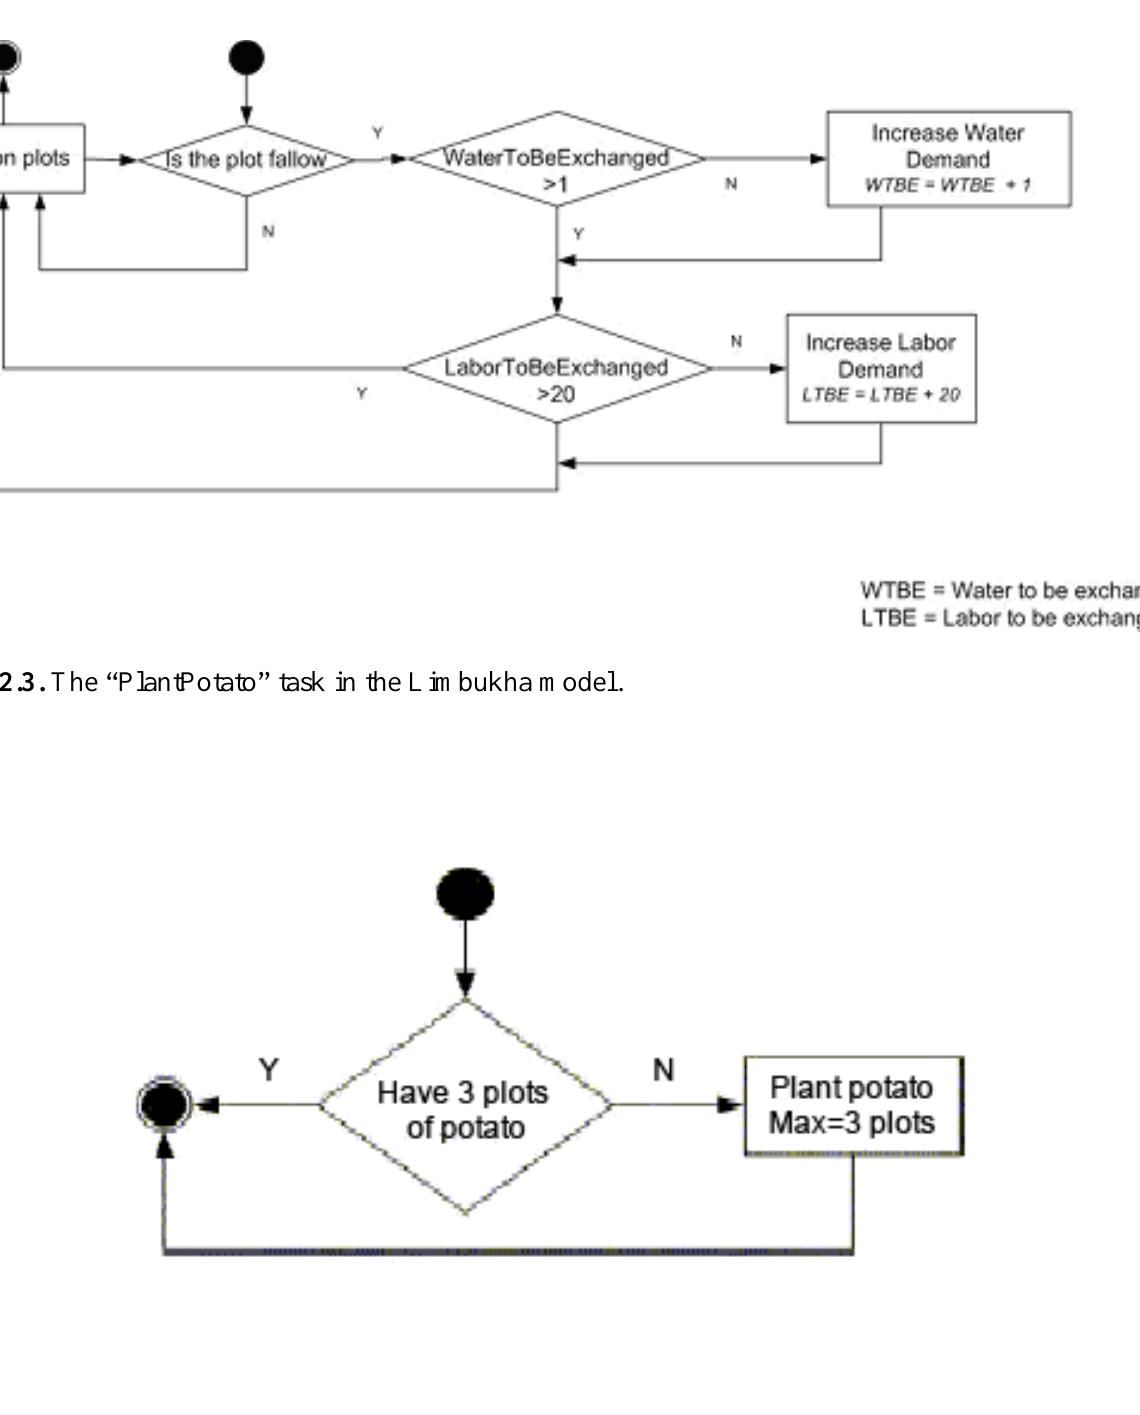
Fig. A2.2. Process for calculating demand for water and labor in the Limbukha model.